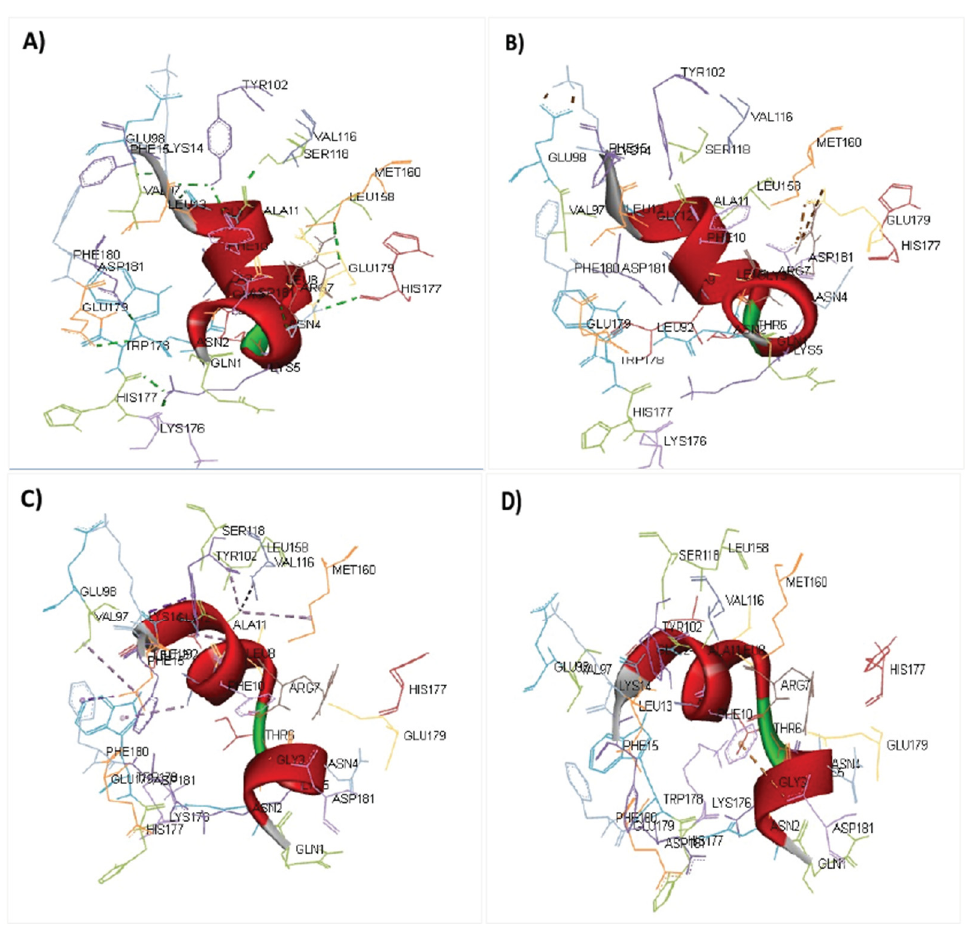
Figure 2. Discovery studio visualization of the different interactions between the epitope and its associated MHC allele: ( A ) conventional hydrogen bonds; ( B ) salt bridge, attractive charge interactions; ( C ) hydrophobic interactions; ( D ) cation–Pi interactions.